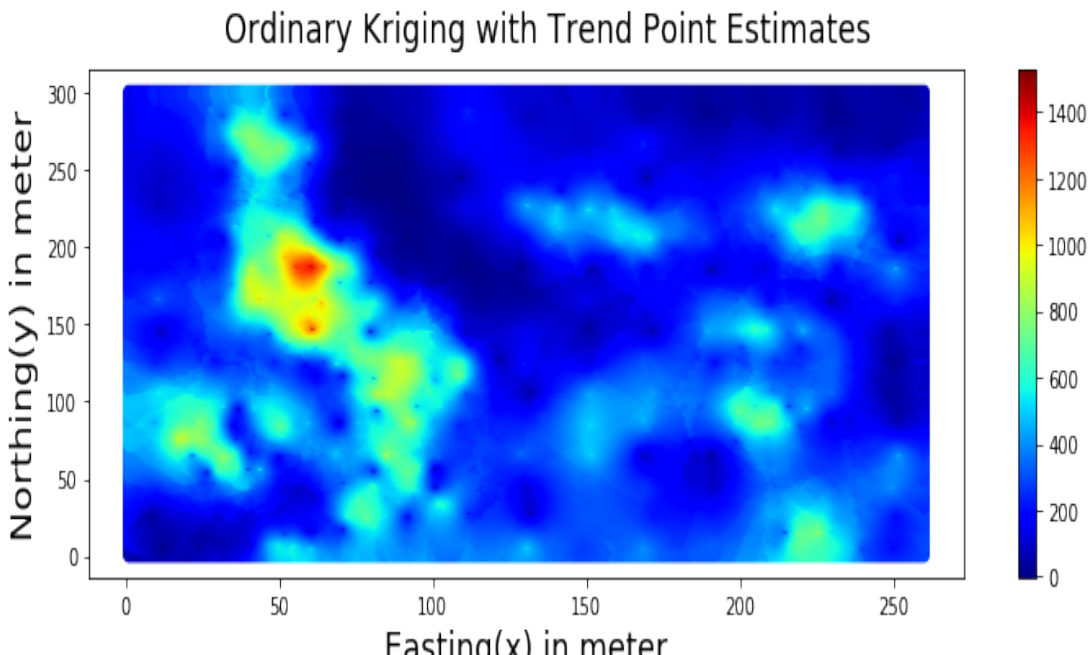
Figure 11. Spatial Estimation of Walkerlake dataset by Ordinary Kriging.